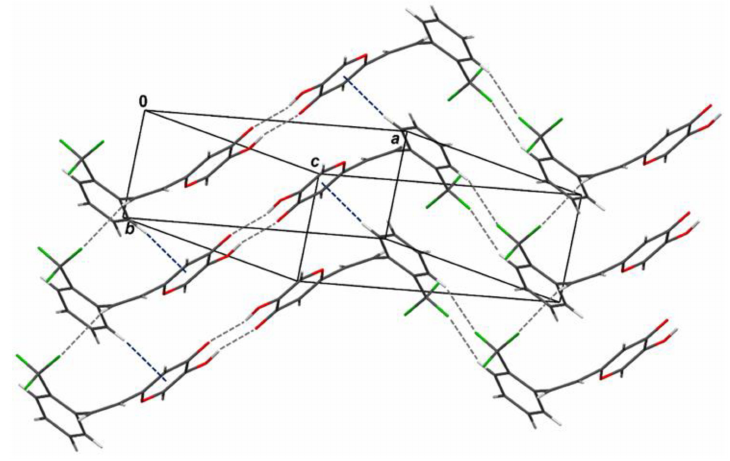
Figure 15. Crystal packing of cis - 2 . The chains are generated by C–H · · · F and O–H · · · O hydrogen bonds parallel to [1–10]. Hydrogen bond C7–H7 · · · F1 and C–H · · · π interactions extend the chains in the direction [010].